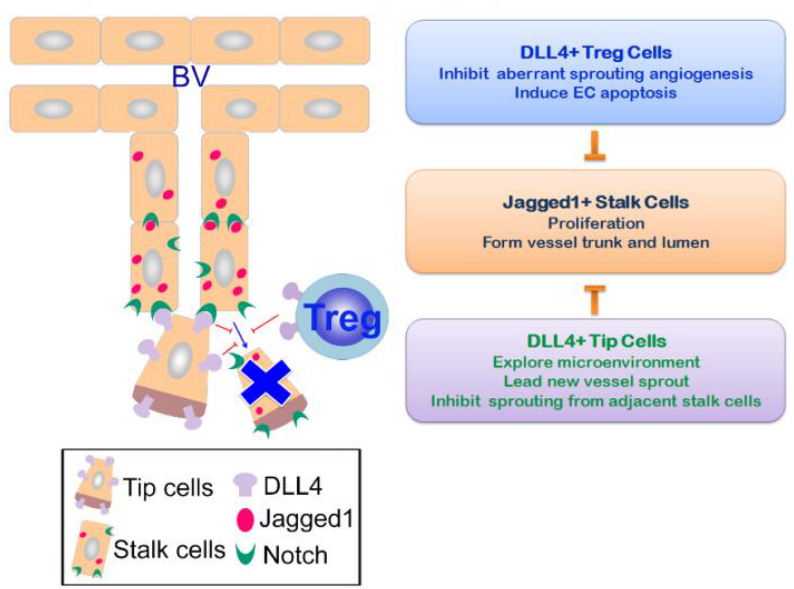
Figure 2. Tregs inhibit sprouting angiogenesis of the airway remodeling by DLL4 signaling. During chronic airway inflammation, DLL4 expression by Tregs is able to ameliorate aberrant angiogenesis of the remodeling airways by inhibiting vessel sprouting. Decreased non-functional angiogenesis within the airway mucosa leads to improved lung function.